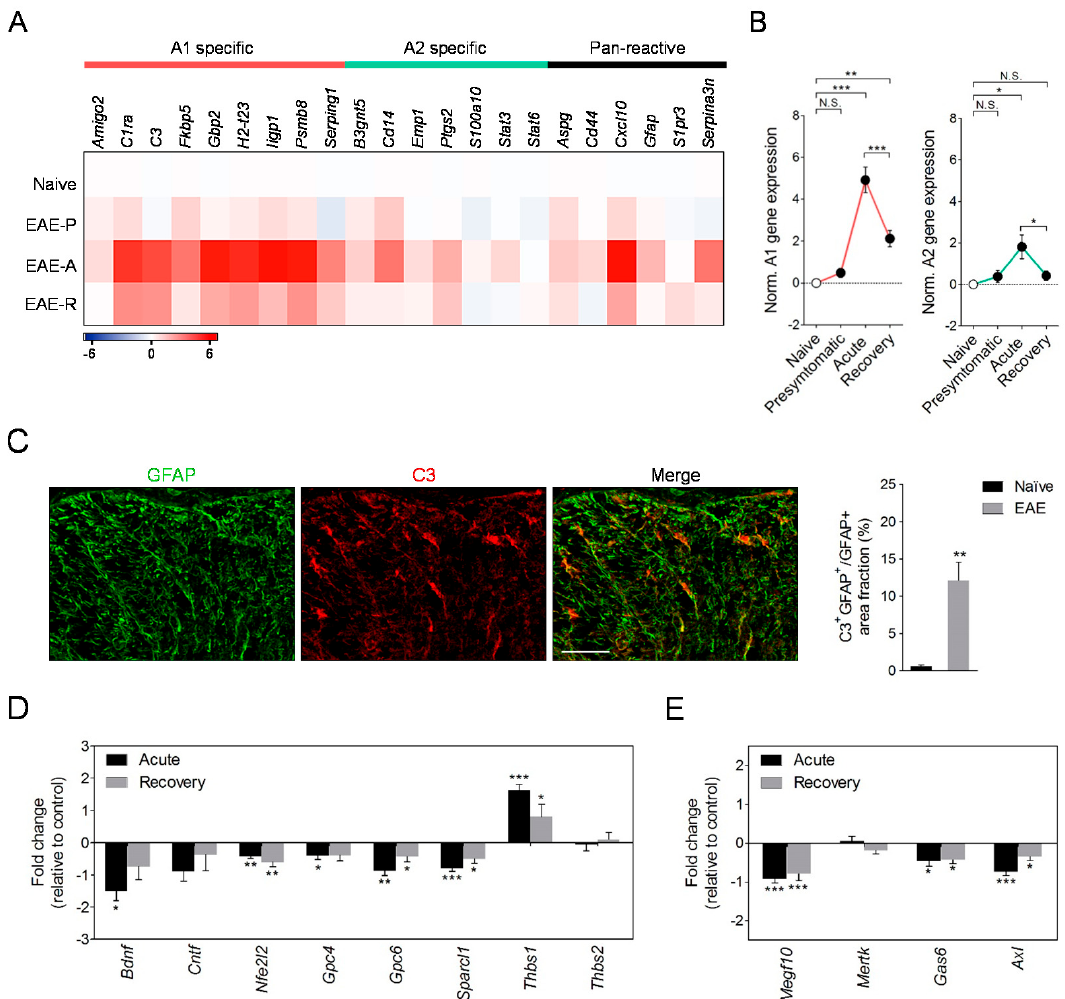
Figure 2. Modulation of astrocytic phenotype during EAE. ( A ) Heat map comparing the mean expression of neurotoxic A1, protective A2, and pan-reactive gene transcripts in astrocytes isolated from mice in the presymptomatic (EAE-P), acute (EAE-A) and recovery (EAE-R) phases of EAE, as determined by RT-qPCR ( n = 5–6 mice group). ( B ) Histogram representation of normalized A1 and A2 gene expression during EAE progression. ( C ) Confocal images and quantification of complement component C3 colocalization with the astrocytic marker GFAP in spinal cord white matter of chronic EAE mice ( n = 3; 35 dpi). Scale bar: 50 µ m. ( D , E ) Fold change in mRNA expression of genes related to neuroprotection and synaptogenesis ( C ) and phagocytosis ( D ) in astrocytes sorted during acute and chronic EAE. Changes in relative expression were determined as log 2 . N.S., not statistically significant. * p < 0.05; ** p < 0.01; *** p < 0.001; referred to naïve astrocytes by Student´s t -tests or Mann–Whitney U -tests; one-way ANOVA followed by Newman–Keuls tests ( B ).